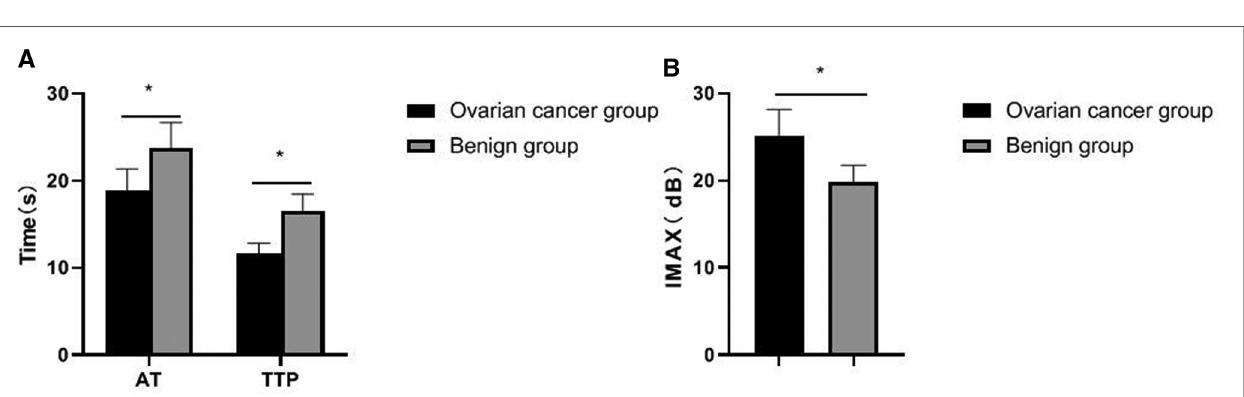
FIGURE 3 | Comparison of ultrasound parameters in patients with ovarian cancer by different stages. ( A ) PI and RI; ( B ) EDV; ( C ) PSV; ( D ) VM.